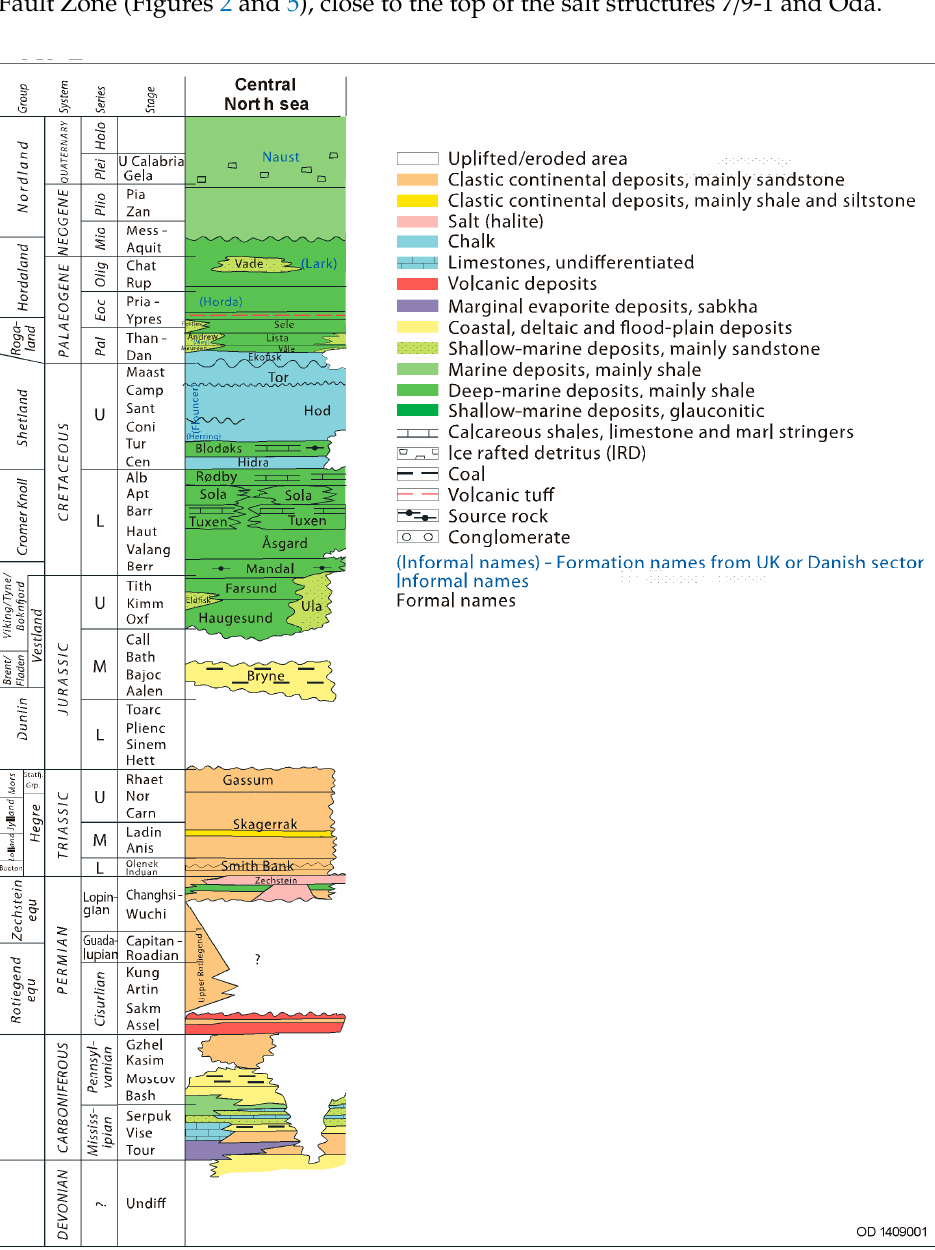
Figure 3. Stratigraphic column from the Central Trough area, modified from Norwegian Petroleum Directorate (www.npd.no).